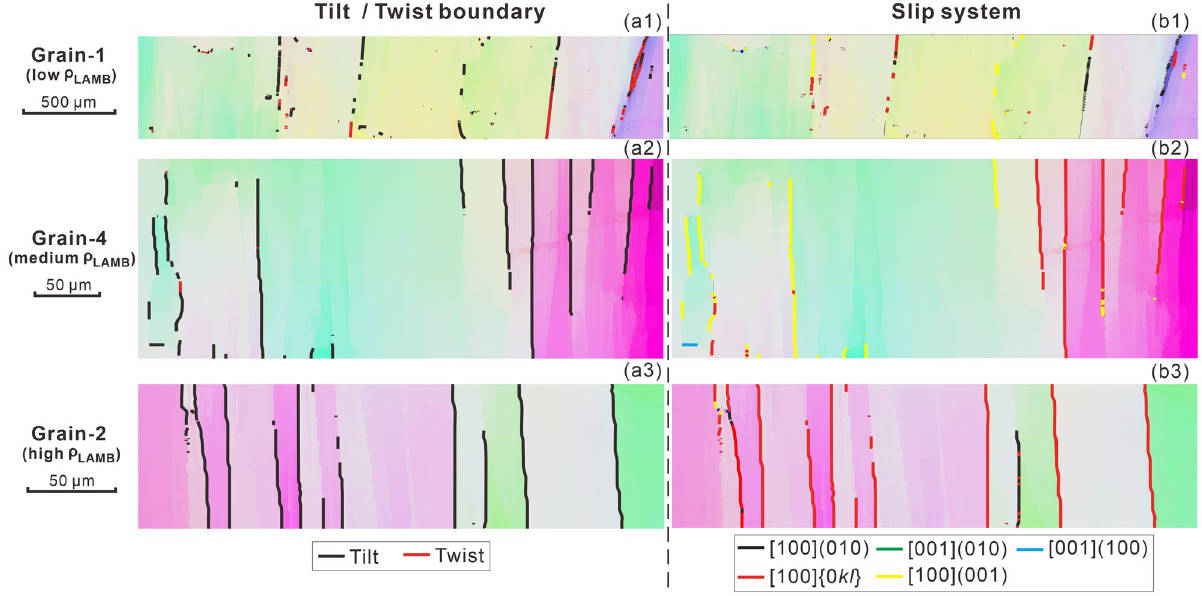
Figure 4. Distributions of the ( a1 – a3 ) tilt and twist SGBs and the ( b1 – b3 ) inferred dislocation slip systems for three representative low-, medium- and high-ρ LAMB olivine grains, same as those in Fig. 3. Results are derived from the step size of 1 According to the geometrical relation between the SGB trace and the axis of rotation, SGB can be divided into tilt (rotation axis aligning subparallel to SGB trace) and twist (rotation axis aligning subperpendicular to the SGB trace) boundaries. The analyses of SGBs retrieved at the step size of 1 μm in all 22 olivine grains show that SGBs are dominantly tilt boundaries, as their percentages are 60.3–99.9%, 49.8–95.9% and 41.1–88.6% for the low-,